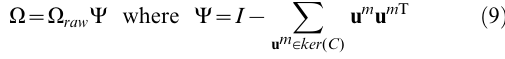
Figure 7 visualizes the difference vector ( w 2 { w 1 ) of prototypes